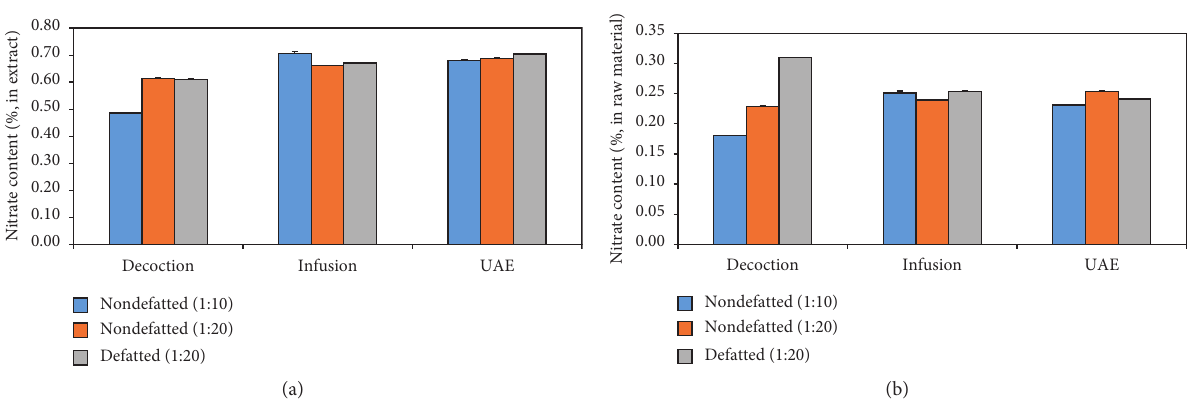
Figure 4: Nitrate content of the C. anisata leaf (a) extract and (b) raw material extracted from different techniques.